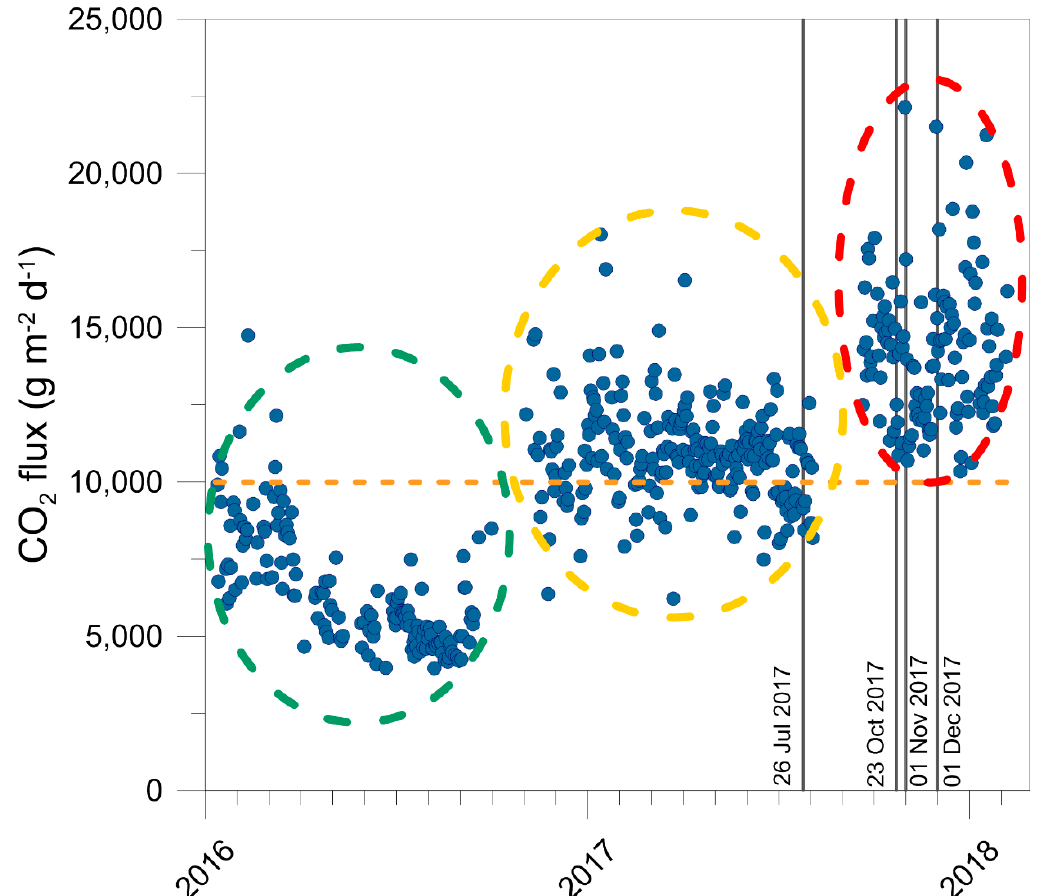
Figure 4. Daily averages (24 measurements/day) of CO 2 fluxes at STR02 station of 2016–2018 period. A strong and sharp increase of soil CO 2 flux is evident: two clear increased degassing families have been recognized (yellow and red dashed circle).